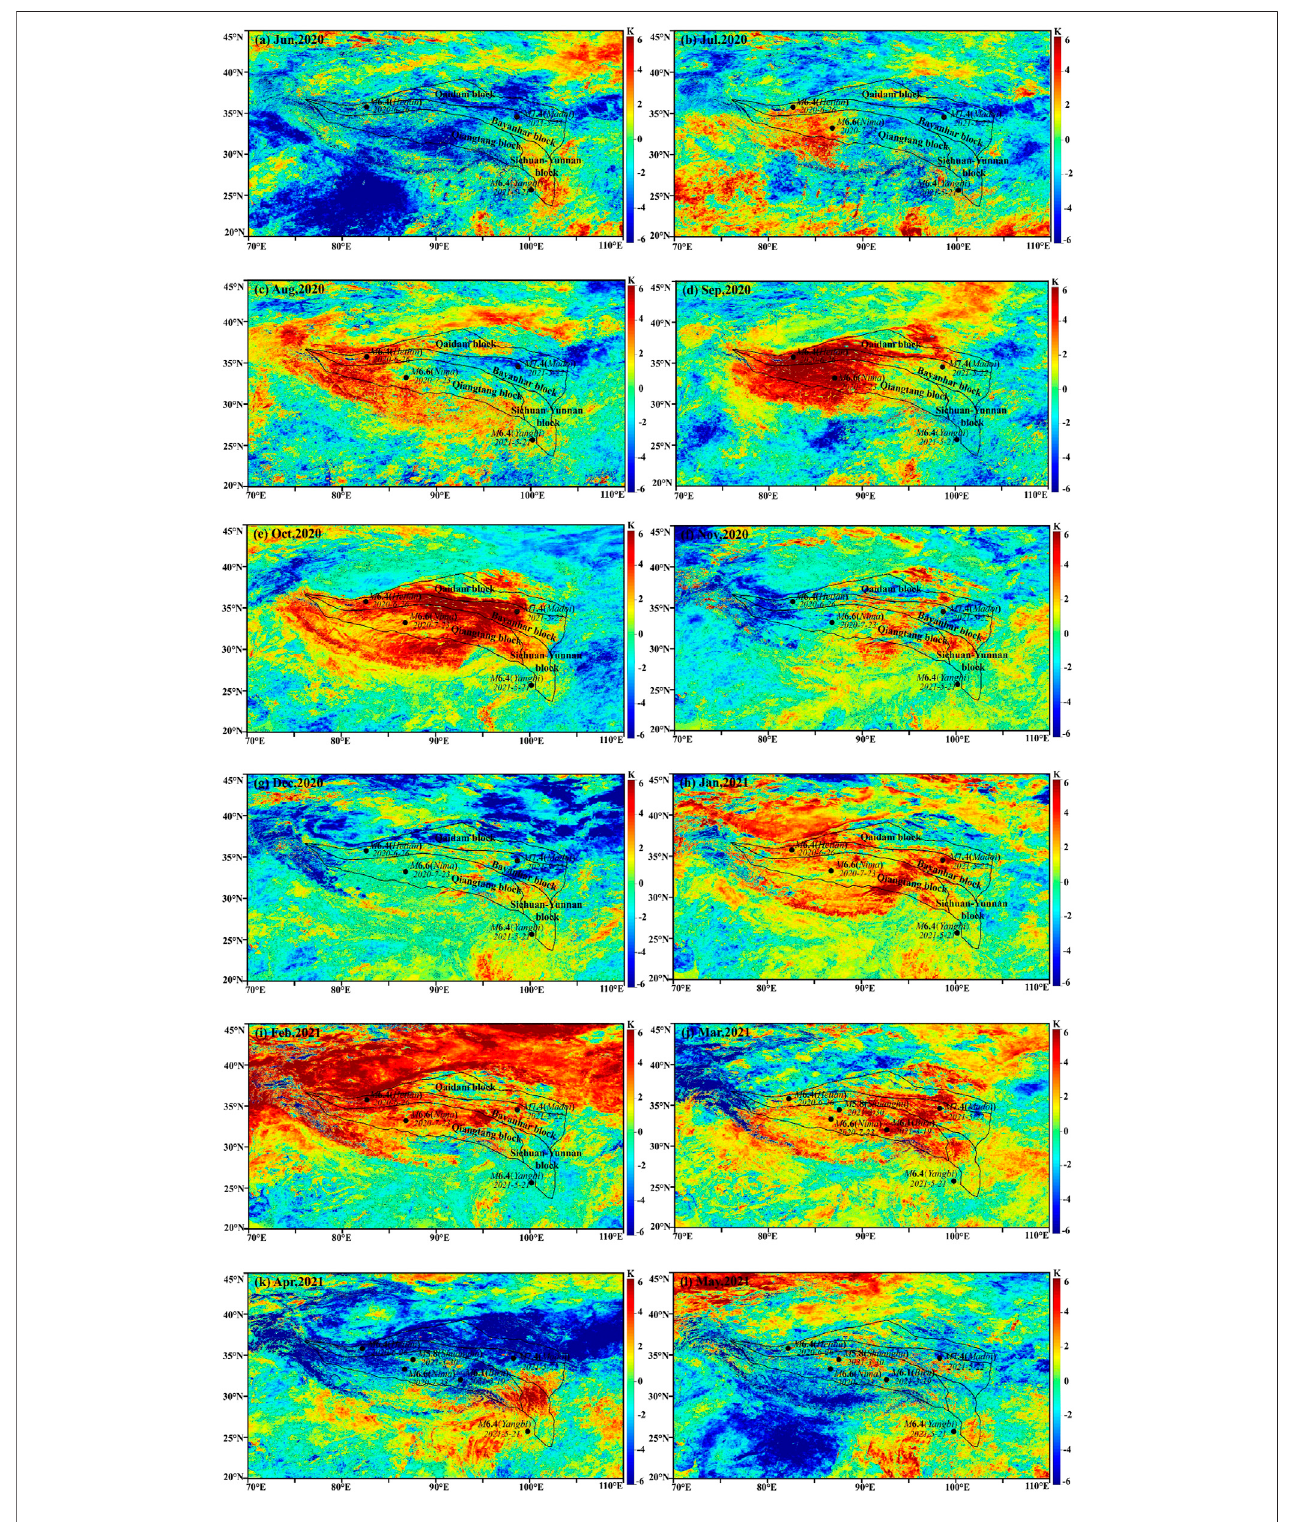
FIGURE 4 | BT anomalies and earthquakes in the Qinghai-Tibetan Plateau (2020.06 (A) -2021.05 (L) ).